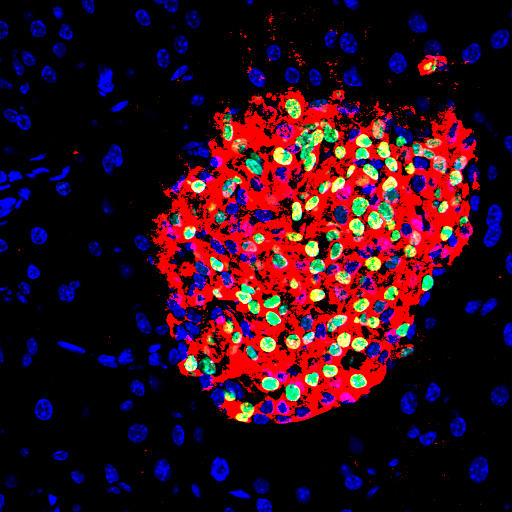
A pancreatic islet stained for insulin (red) and all nuclei (blue), including surrounding exocrine tissue. In addition, some β cell nuclei are labeled with GFP to monitor cell division.